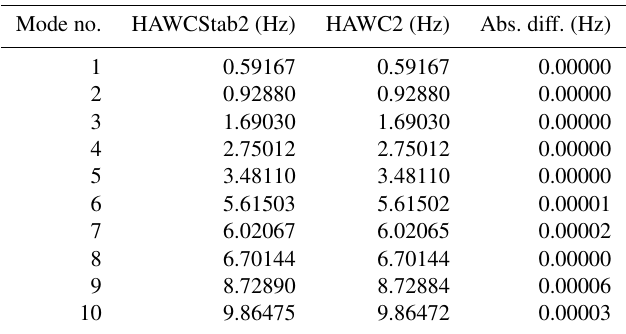
Table 4. Natural frequency comparison of a flap–twist to feather coupled DTU 10MW RWT blade ( γ y = − 0 . 2) obtained with HAWCStab2 and HAWC2.